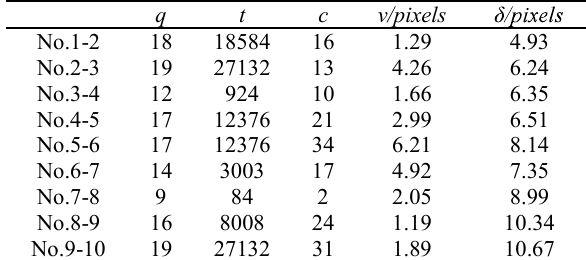
Table 4. The comparison of M, N1 and N2 in dataset I ( pixels )